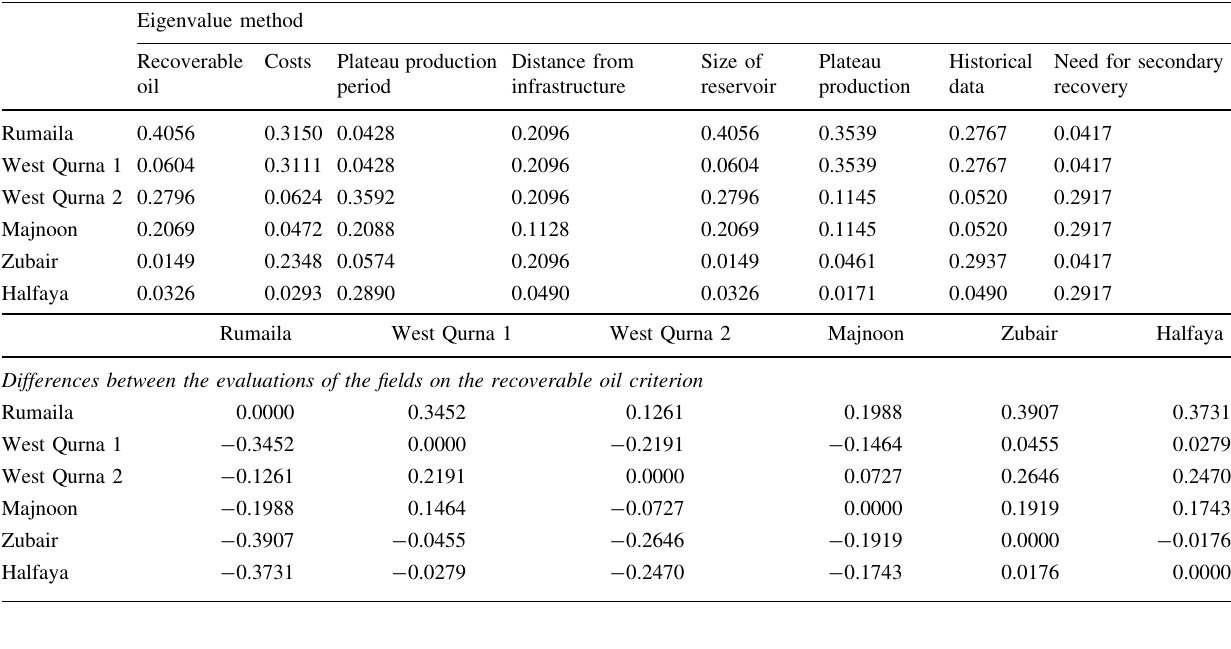
Table 6 PROMETHEE—difference between alternatives priorities